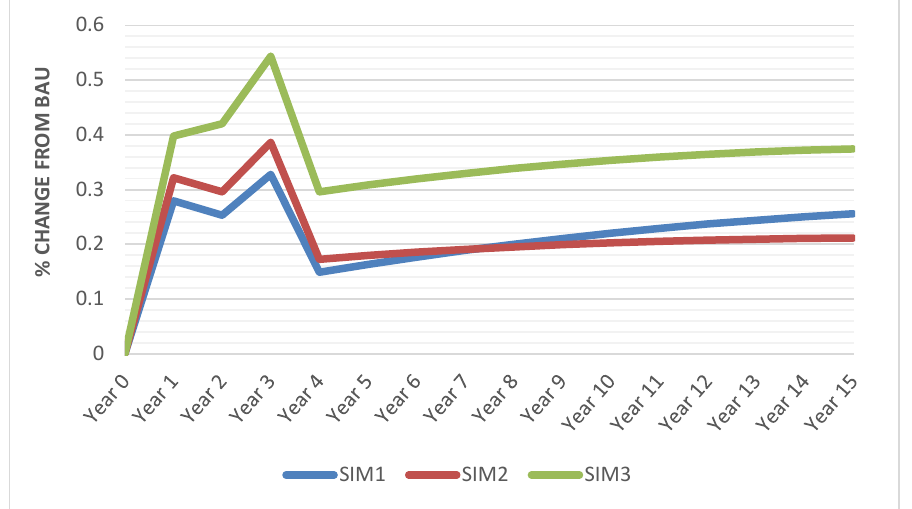
FIGURE 4: Changes in aggregate formal labour demand (% from BAU) Source: Authors’ calculations from simulation